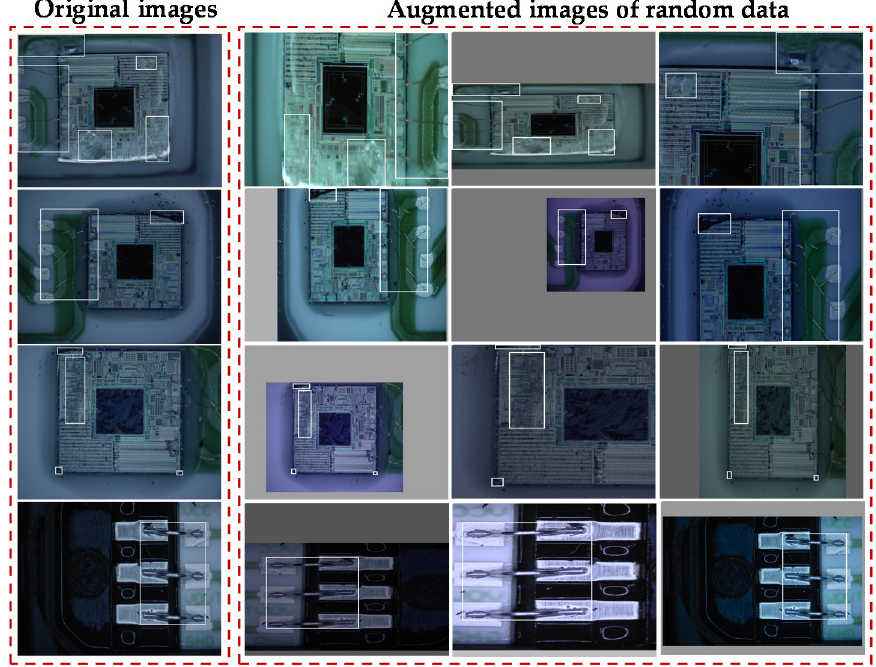
Figure 7. Data augmentation of five kinds of defect images of the MEMS pressure sensor in Figure 3.